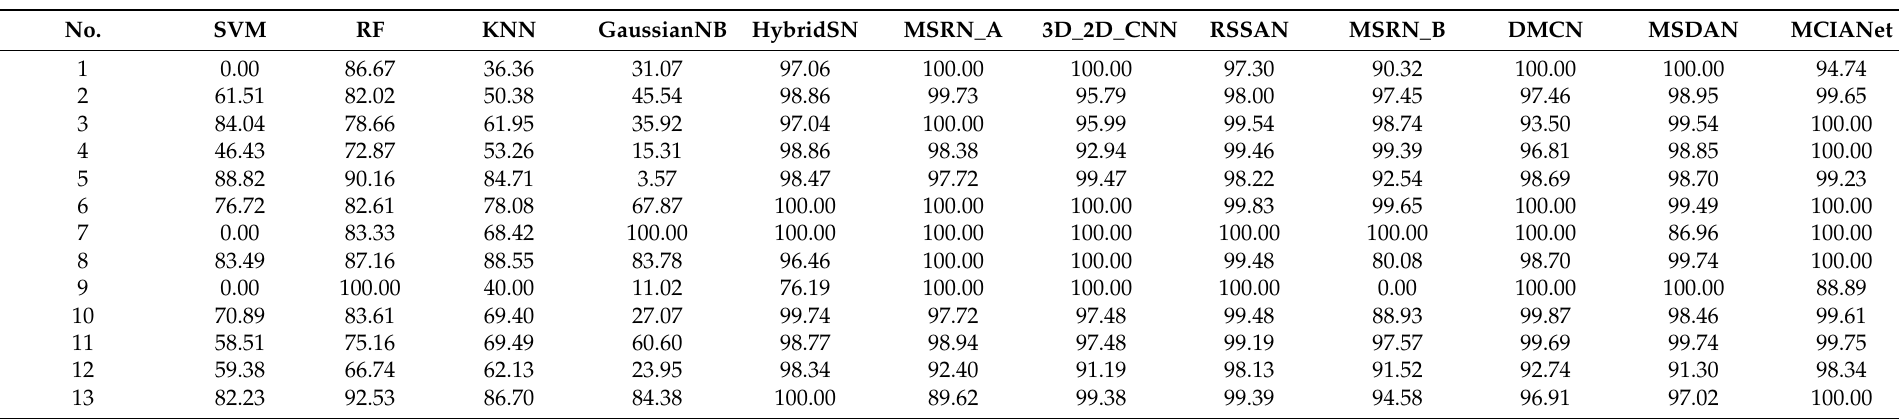
Table 5. The classification results on the IP